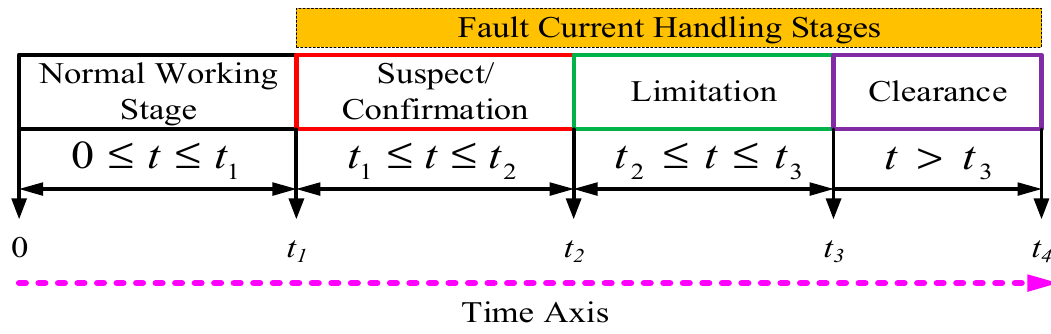
Figure 4. Different operating periods with fault current handling stages.